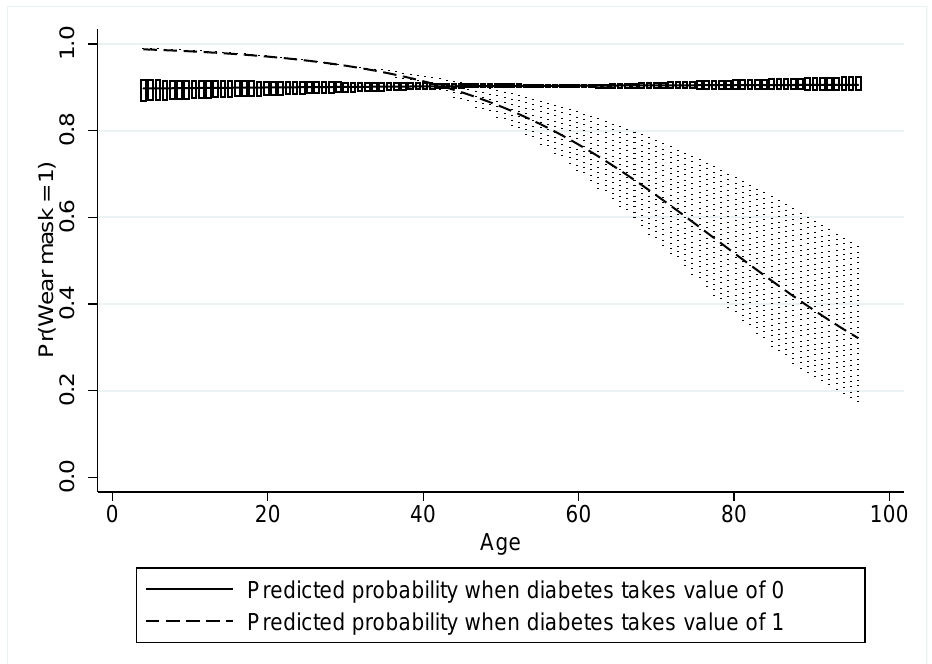
Figure 10. The interaction of respondent age and awareness of household diabetic under mask wear- ing.